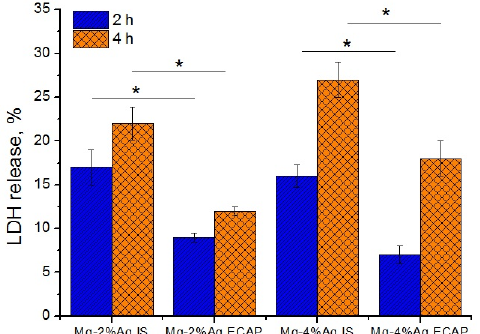
Figure 6. Increasing lactate dehydrogenase (LDH) level in the cell growth medium in comparison with the control (* p < 0.05). Time of incubation of tumor cells with alloys of Mg-2.0%Ag and Mg-4.0% Ag in the initial state (IS) and ECAP-treated (regime 2) state-2 and 4 h. An increase in the level of LDH is associated with damage to the cell membranes due to the cytotoxic e ff ects of the alloys (Figure